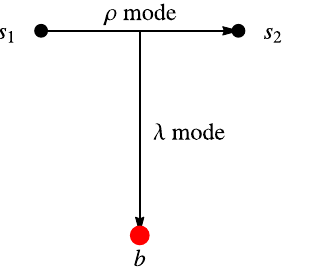
Fig. 1 The (cid:2) b system with λ − or ρ − mode excitation. The s 1 and s 2 stand for the strange quarks, and b corresponds to the bottom quark